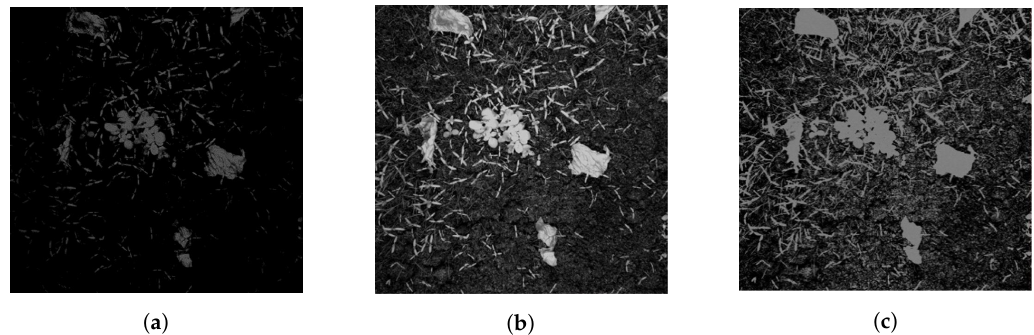
Figure 3. Responses of the red ( a ), green ( b ), and blue ( c ) camera channels, in controlled illumination.